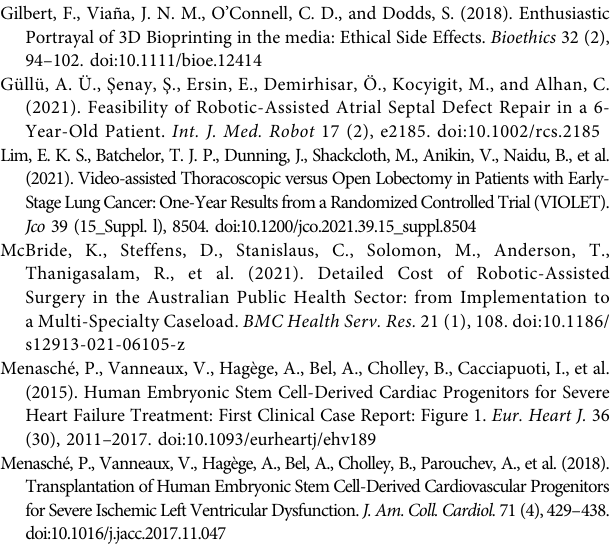
Supplementary Figure S2 | Outer body design for the “ Claw ” minimally invasive heart patch transplantation instrument in early-stage development. (A) Initial design with rounded-base triangle forming the claw compartment where patch would sit. (B) Initial design with tapering rectangular claw compartment. Both initial designs shown here do not completely enclose the patch compartment (a feature of the subsequent fi nal design). Supplementary Figure S3 | Rack and Pinion mechanism technical details. Supplementary Figure S4 | Plate holder technical details. Supplementary Figure S5 | Plate holder working mechanism with combination of linkages. (A) L-link (B) H-link (C) T-link. Supplementary Figure S6 | Shell-Beak Design. First-generation (A,B) Shell-Beak designwithapatchdispensersystem.Thecardiacpatchisheldinaninfolded “ shell ” position and then outfolded with opening of the “ beak. ” (C) External structure (D) Internal structure. This instrument was designed to deploy a patch with a diameter largerthantheinstrument.Ellipticalpatcheswithshape-memorycouldpotentiallybe out-folded and deployed with this design. Supplementary Figure S7 | “ Umbrella ” Design. Initial designs for a protrusion- based patch deployment instrument which were subsequently developed into the fi nal HeartStamp